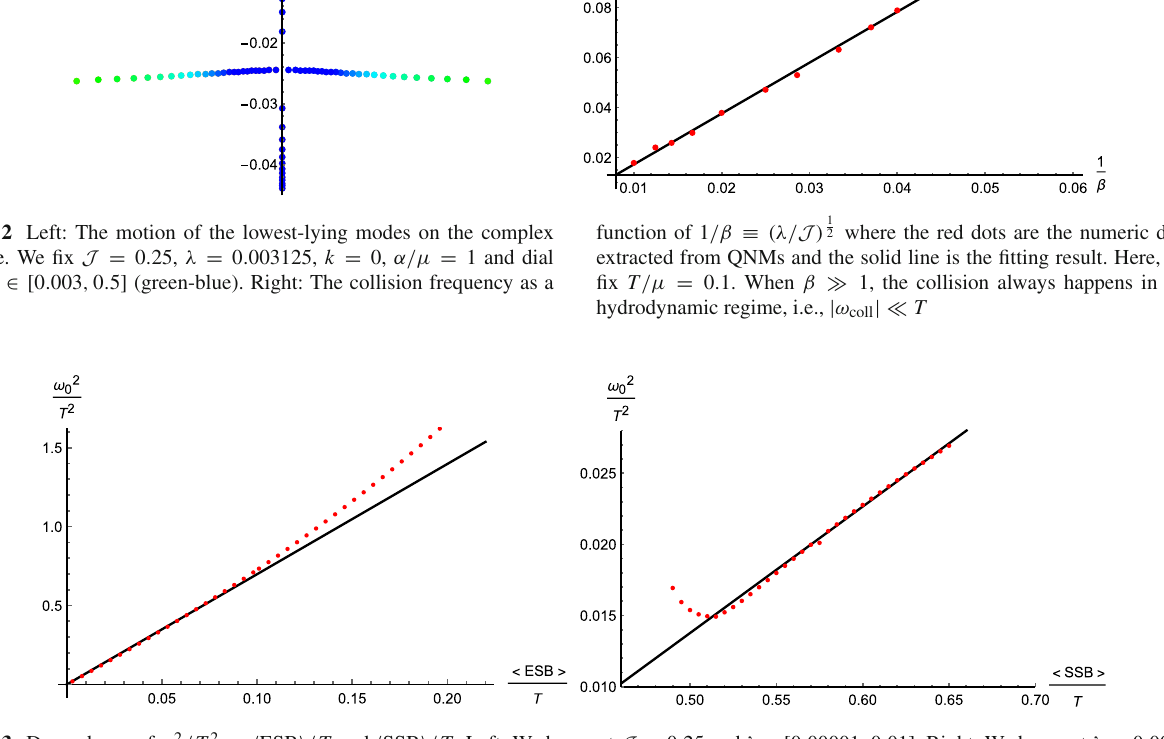
/ T 2 on (cid:8) ESB (cid:9) / T and (cid:8) SSB (cid:9) / T . Left: We have set J = 0 . 25 and λ ∈ [ 0 . 00001 , 0 . 01 ] . Right: We have set λ = 0 . 0001 Fig. 3 Dependence of ω 2 0 and J ∈ [ 0 . 03 , 0 . 65 ] . In both panels, we have fixed α/μ = 1 and T /μ = 0 . 1